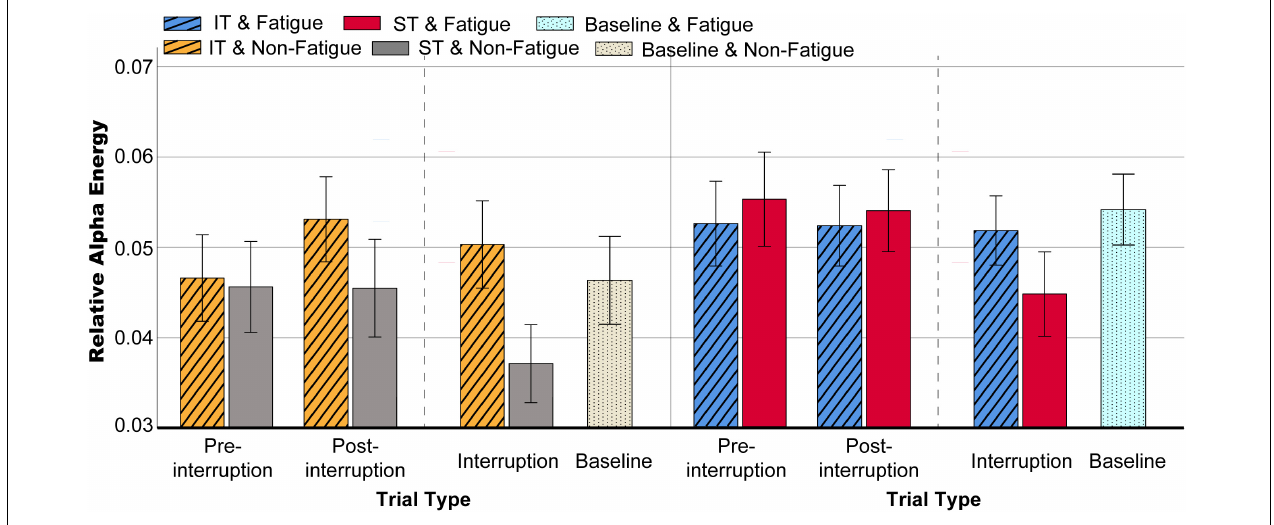
FIGURE 11 | Mean relative alpha energy in various conditions. Error bars indicate 95%